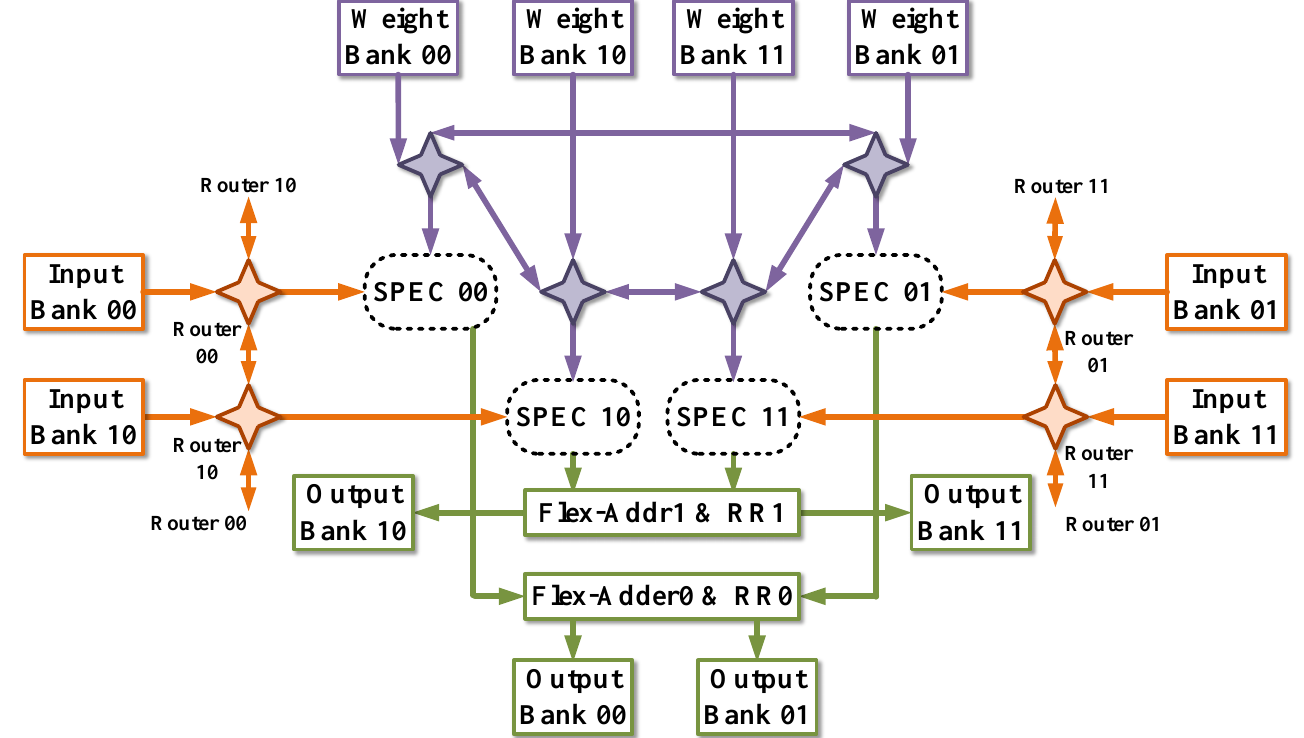
Figure 8. An example of an overall architecture with 2 × 2 SPECs. The RR module contains re- quantization and ReLU units. Four-pointed stars denote routers from